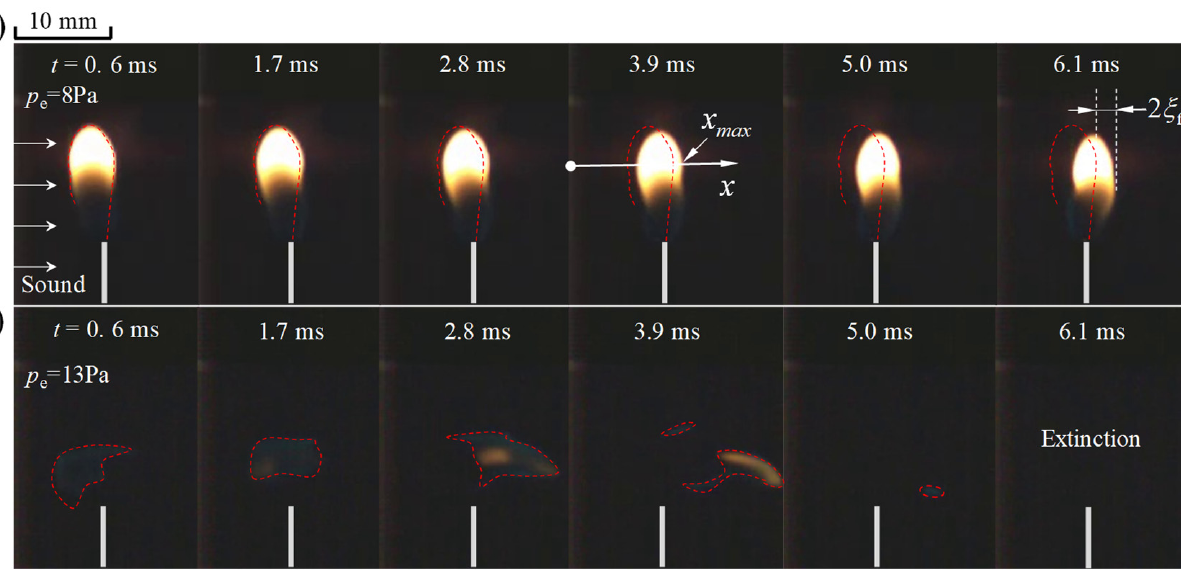
Figure 3. Periodic oscillation of the flame aroused by the speaker with local sound (120 Hz) pressure: ( a ) p e = 8 Pa and ( b ) p e = 13 Pa.